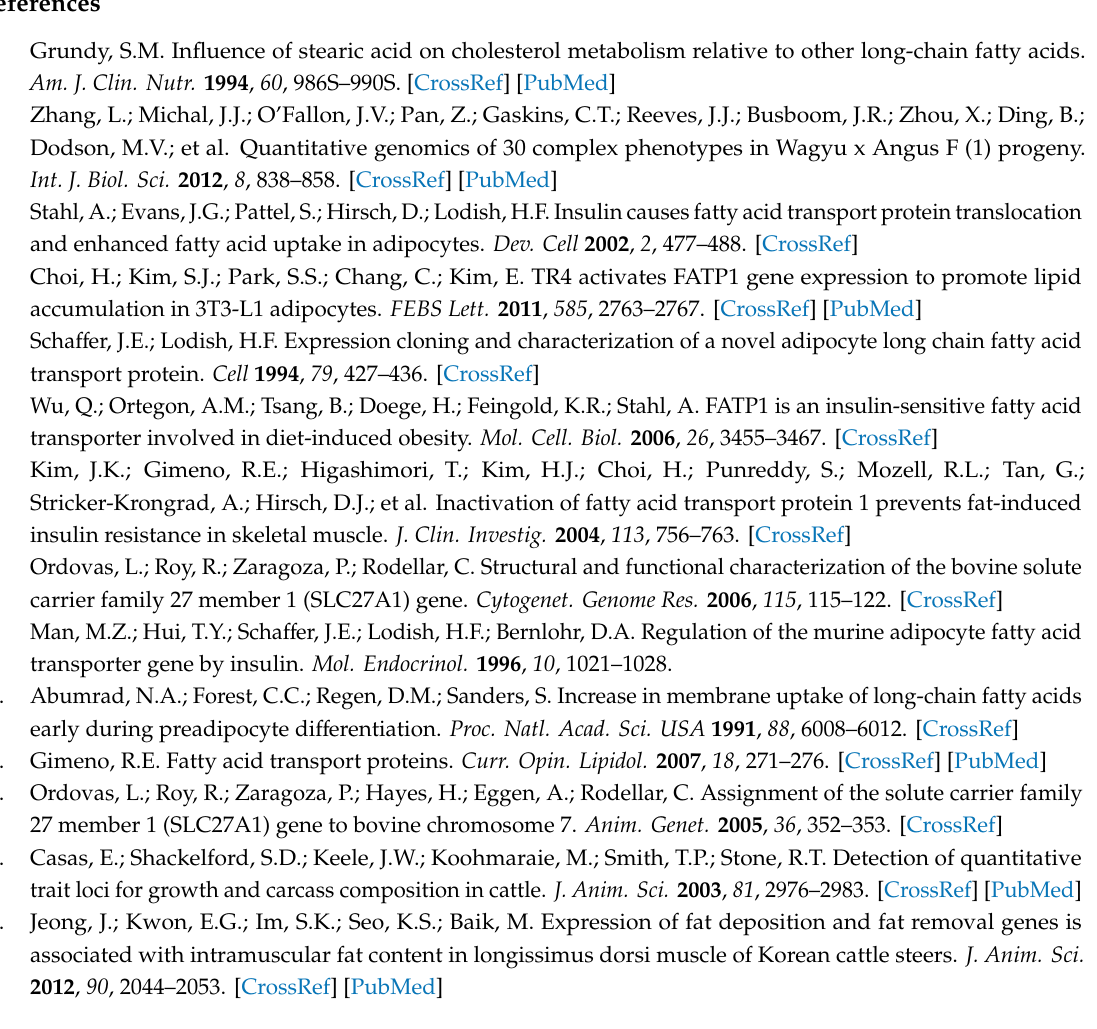
Table S1: Primers used in the expression and functional analysis of the SLC27A1